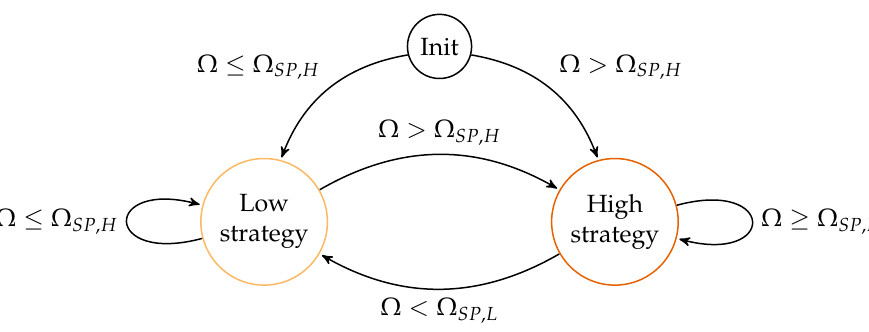
Figure 3. The state machine for the LUT selection in the critical speed